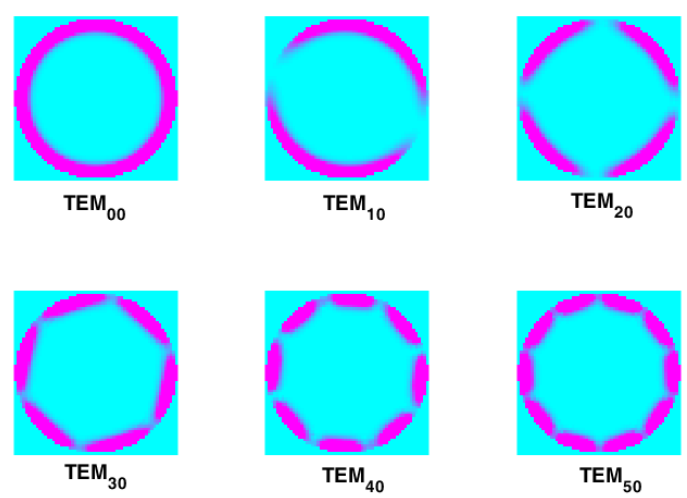
Figure 5. Optical intensity distribution of the different modes.